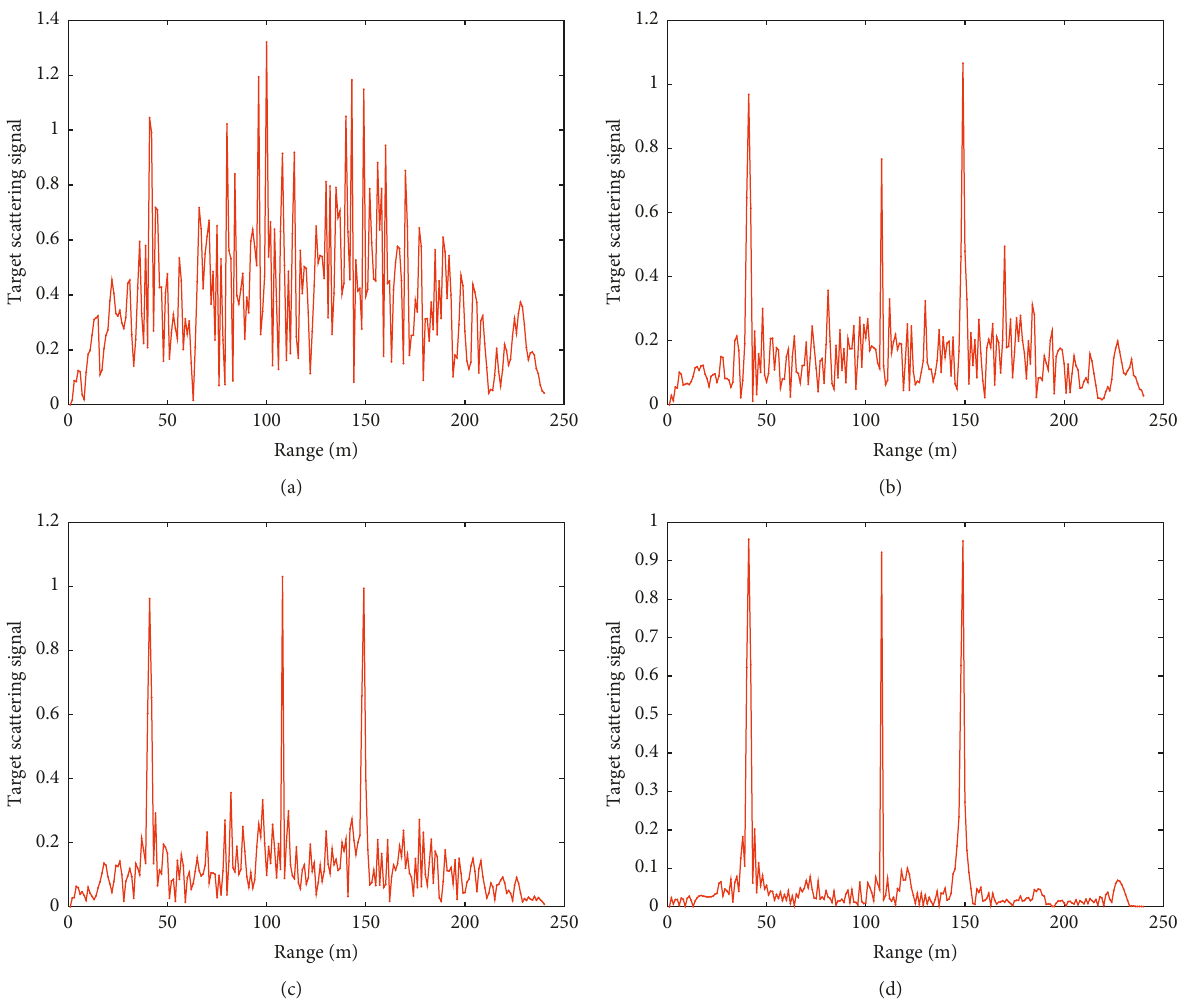
Figure 11: Target scattering signals profiles at (a) iteration 1, (b) iteration 5, (c) iteration 10, and (d) iteration 20, Algorithm